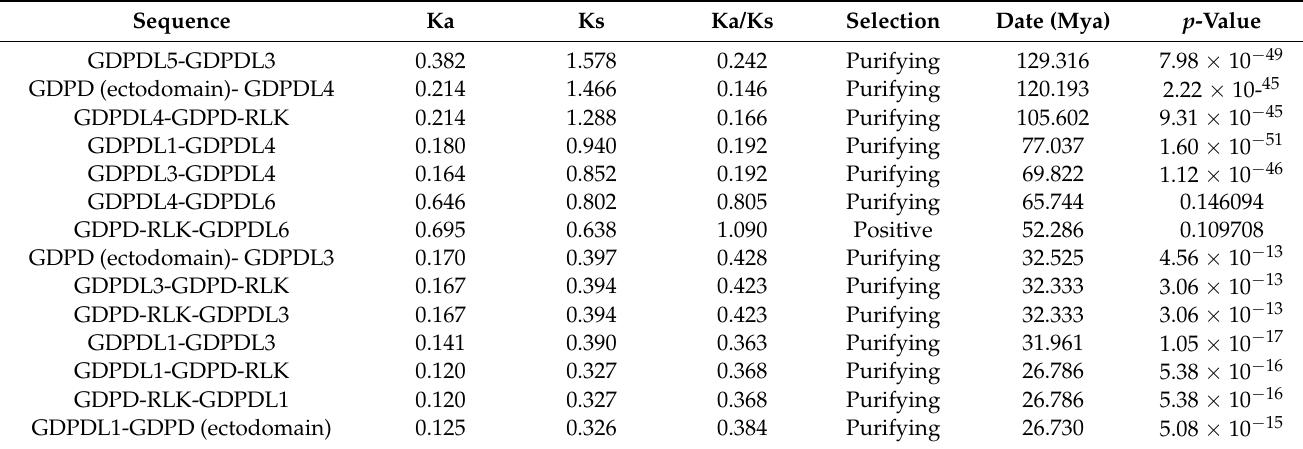
Table 10. Molecular evolution analysis of the